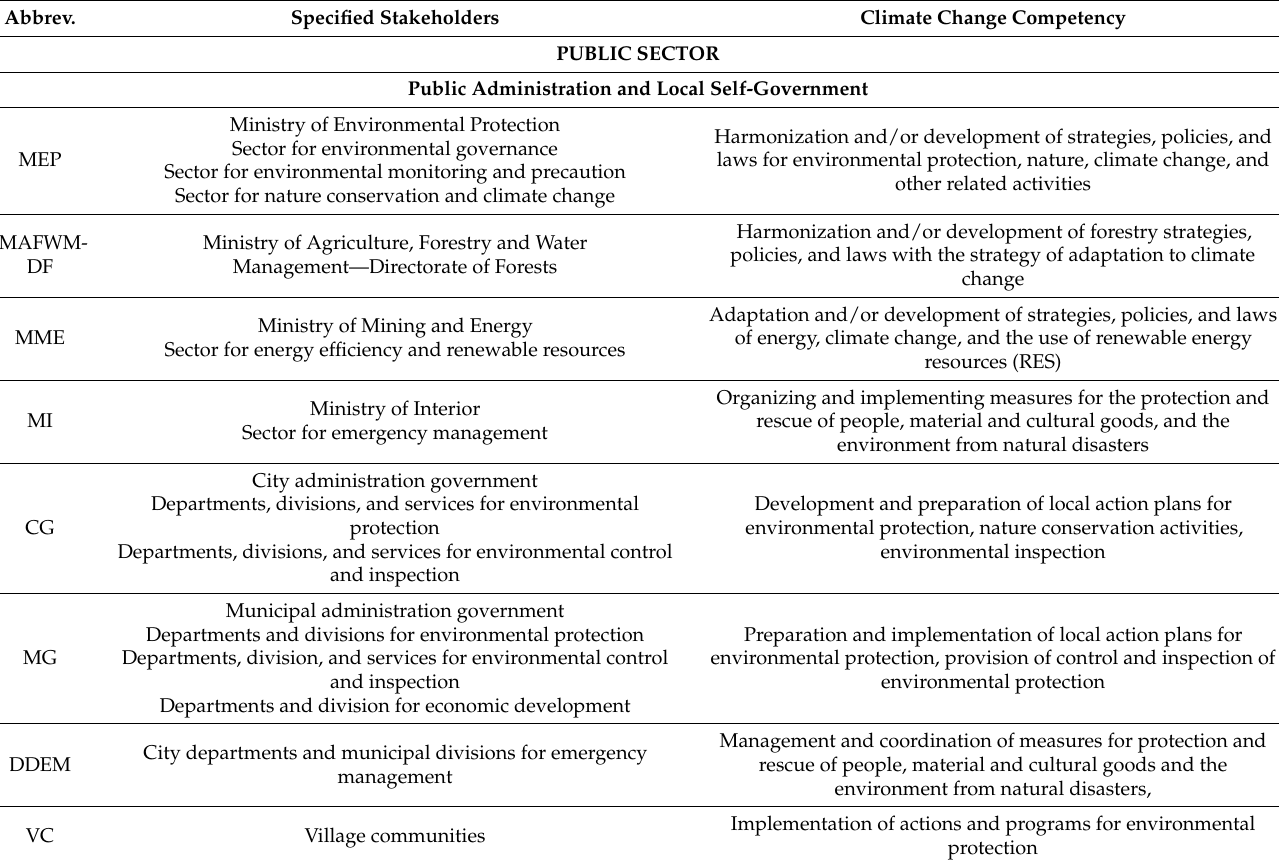
Specified public sector organizations in forestry and nature conservation with climate change competency